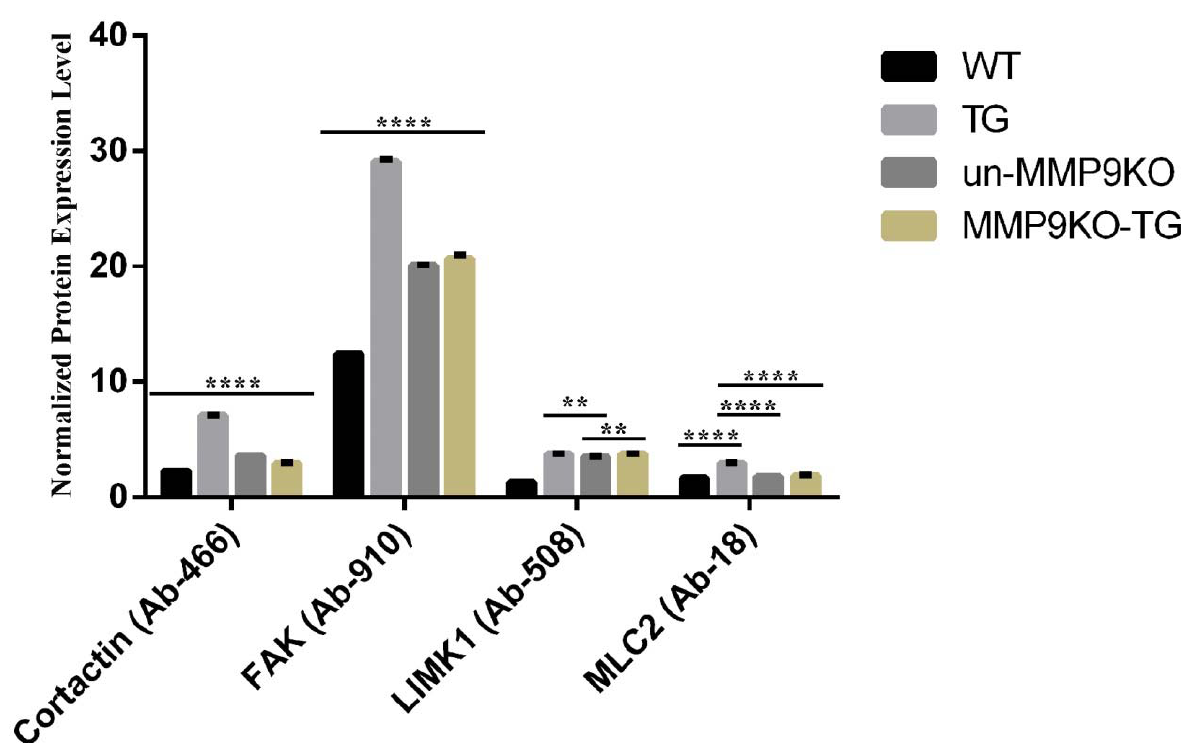
Figure 3. Graphs showing the average signal of protein expression for selected proteins. Cytoskeletal protein array analysis was conducted using LEC explants from wildtype (control) and MMP9KO mice were left untreated (un-MMP9KO) or with treated with 500 pg/mL TGF- β for 72 h (MMP9KO-TG). Cortactin, focal adhesion kinase (FAK), lim-domain kinase-1 (LIMK1) and myosin light chain-2 (MLC2) were analyzed. Data was normalized to the median GAPDH and then averaged. A 2-way ANOVA with multiple comparisons was performed and the data was graphed using Graphpad Prism. Error bars indicate ± standard deviation ( n = 3 independent experiments, where 10 µ g of protein per treatment was used for each experiment; ** p < 0.01 **** p < 0.0001). For Cortactin and FAK, p < 0.0001 across all treatment groups i.e., WT vs. TG or un-MMP9KO or MMP9KO-TG, TG vs. un-MMP9KO or MMP9KO-TG and un-MMP9KO vs. MMP9KO-TG. For LIMK1, p < 0.0001 WT vs. other treatments; p < 0.01 TG vs. un-MMP9KO and un-MMP9KO vs. MMP9KO-TG. For MLC2, p < 0.0001 WT vs. TG, TG vs. un-MMP9KO and TG vs. MMP9KO-TG.